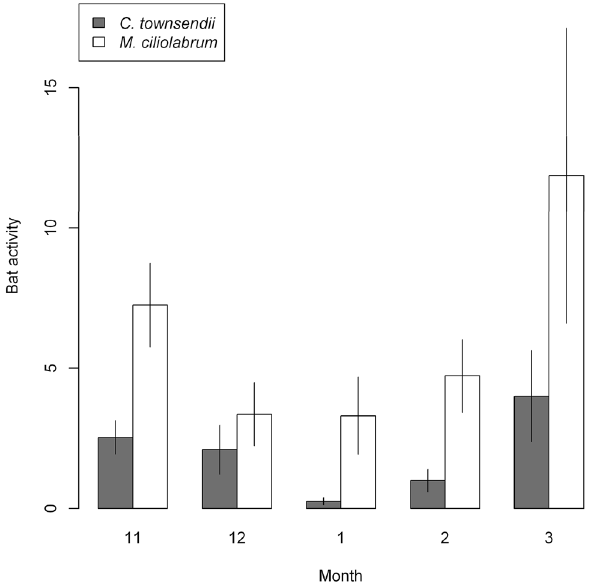
Figure 1. Mean (± 95% CIs) bat activity (files/night) averaged in 9 hibernacula for Townsend’s big-eared bats ( Corynorhinus townsendii ) and western small-footed myotis ( Myotis ciliolabrum ) by month in southeastern Idaho, USA, from 2011 to 2018.